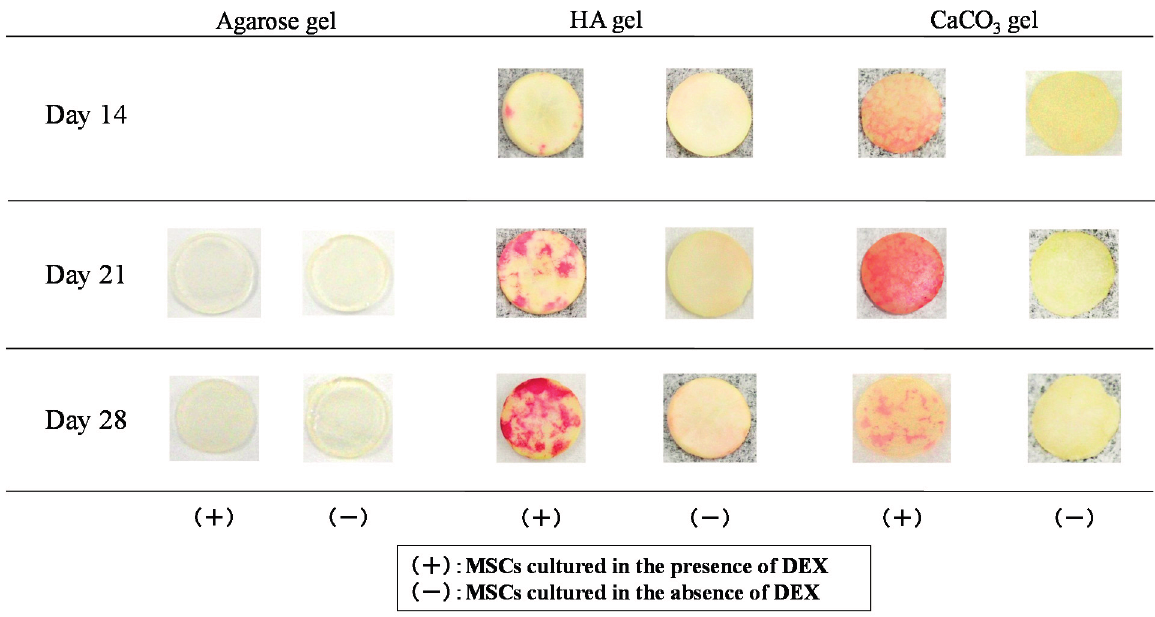
Figure 4. Alkaline phosphatase (ALP) staining of MSCs cultured in the presence (Dex (+)) or absence (Dex ( − )) of dexamethasone on agarose, HA/agarose, and CaCO 3 /agarose gels. Cultures were performed for 14, 21, and 28